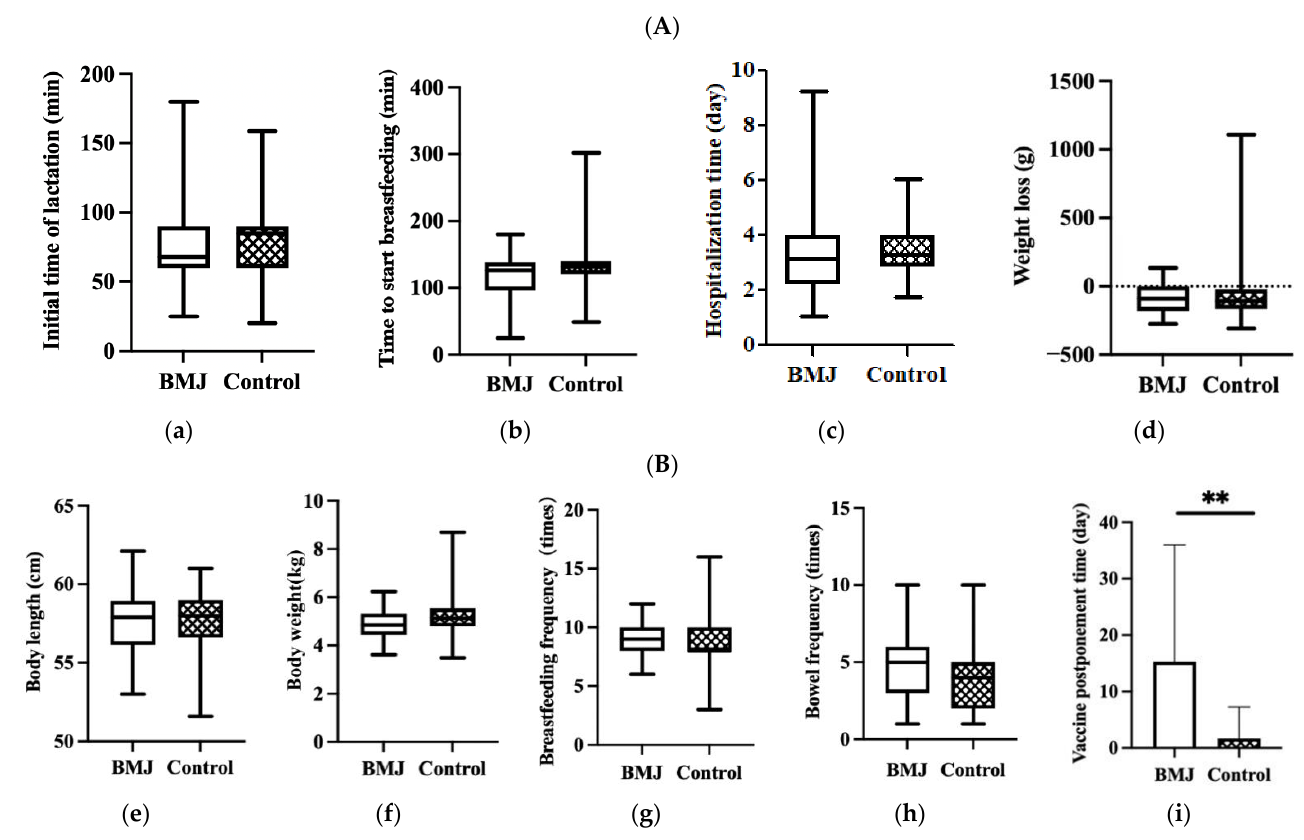
Figure 2. ( A ) Feeding status during hospitalization, ( a ) initial time of lactation, ( b ) time to start breastfeeding, ( c ) hospitalization time, ( d ) weight loss. Error bars represent standard errors. ( B ) Status of growth and feeding of 42-day infants, ( e ) body length, ( f ) body weight, ( g ) breastfeeding frequency, ( h ) bowel frequency, ( i ) vaccine postponement time. Error bars represent standard errors. ** indicates p < 0.001. Table 3. Comparison of nutrient concentrations in breast milk between BMJ group and control